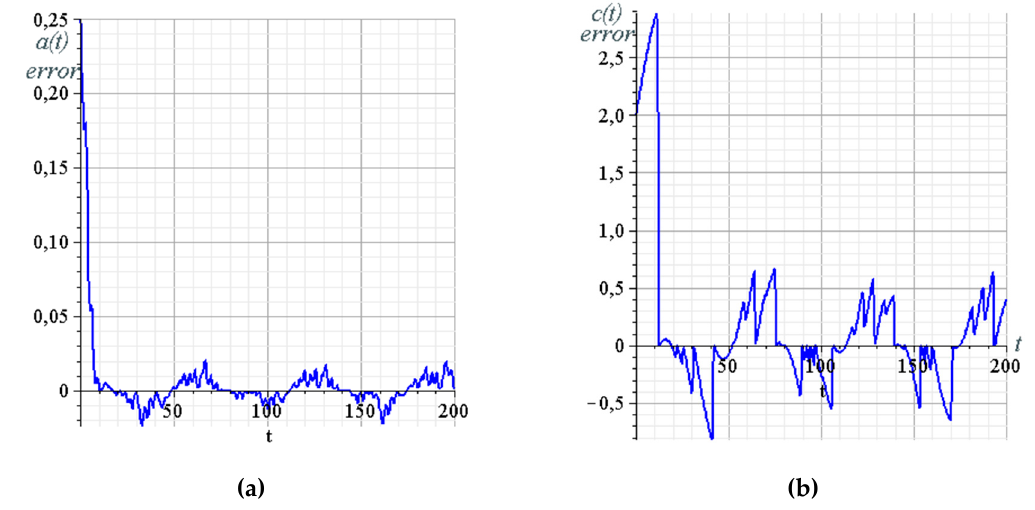
Figure 17. General block diagram of a synergetic observer communication system. Here: a , b , c are the known parameters of the chaotic generator model; a*(t) and c*(t) are the modulated parameters; Z(t) is the Rössler transformed system (2) variable; Z noise (t) is the Z(t) variable with noises admixed in the transmission media; a^(t) and c^(t) are the estimated modulated parameters; µ 1 (t) and µ 2 (t) are the initial useful signals; µ 1 ^(t) and µ 2 ^(t) are the reconstructed useful signals; and α is the observer tuning parameter. Table 2. Example of steps for our synergetic observer design procedure for Rössler generator. Design Step